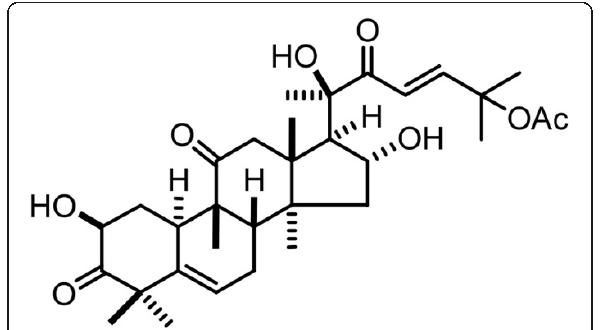
Figure 1 Chemical structure of cucurbitacin B (25-acetoxy- 2 β ,16 α ,20 β -trihydroxy-9 β -methyl-19nor-10 α -lanosta-5,23-diene-